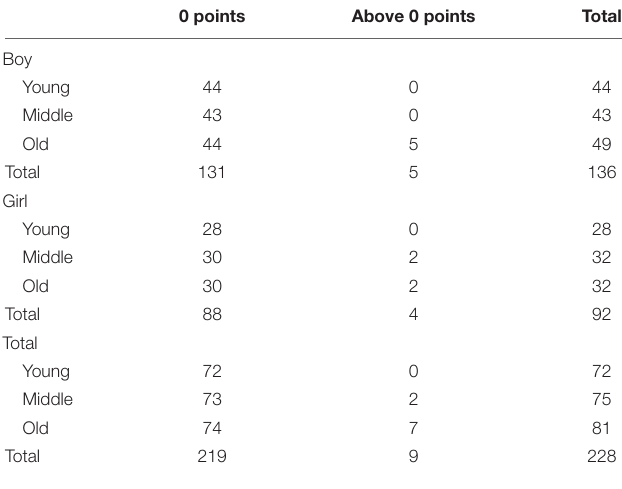
TABLE 1 | Distribution of subjects with different pre-test scores on the length-inconsistent